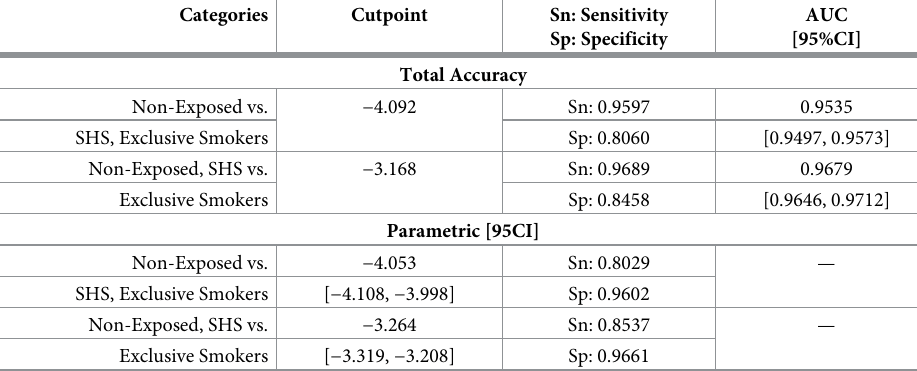
Table 9. Tobacco smoke exposure (N = 16,990). Cutpoints of the natural log of urinary NNAL [ng/ml] discriminating tobacco smoke exposure levels. Cutpoints were selected from cumulative ROC curves with Total Accuracy criterion and computed parametrically. Non-proportional odds were assumed among exposure